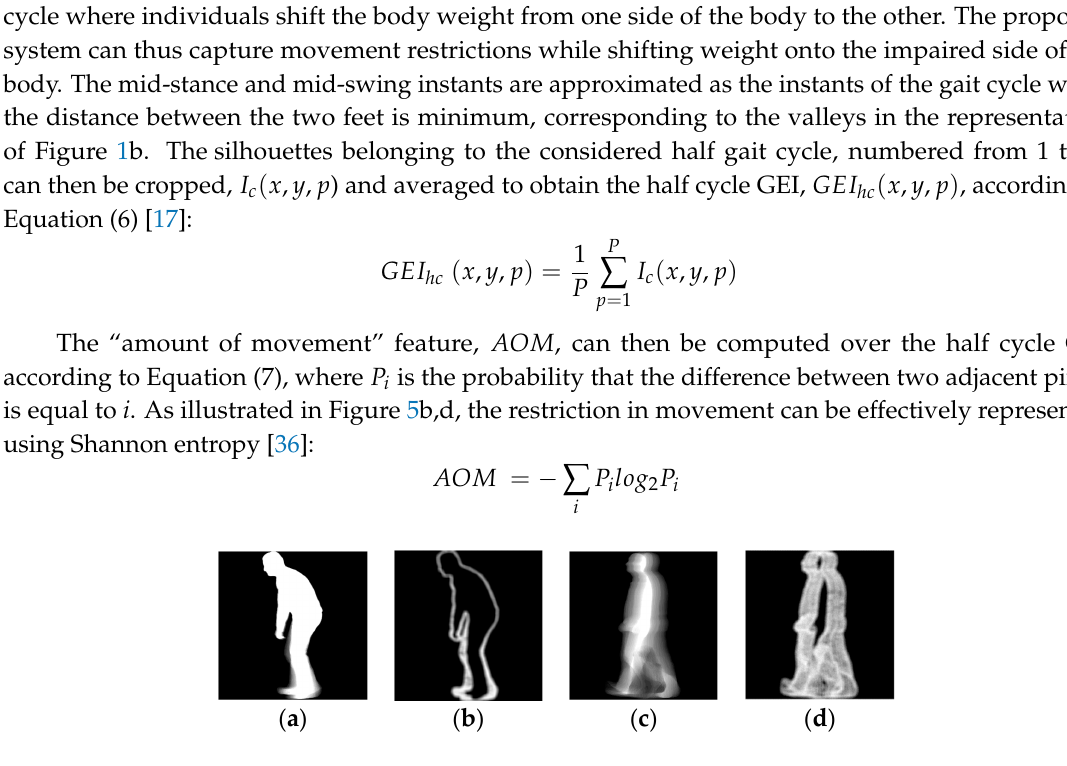
Figure 5. Half cycle GEI computed using impaired ( a ) and healthy ( c ) gait silhouettes, and the corresponding entropy representations ( b , d ).